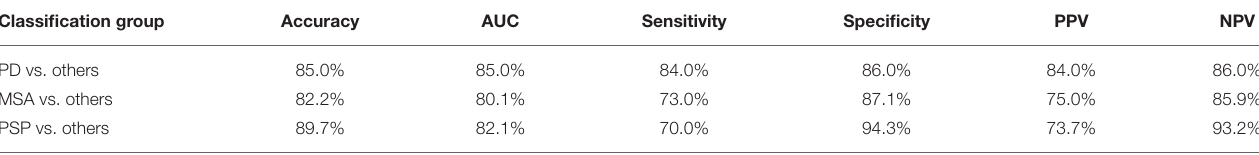
TABLE 3 | Diagnostic performances of the proposed computer-aided classification framework for the binary classification of different parkinsonian disorders. Classification group Accuracy AUC Sensitivity Specificity PPV NPV PD vs. others 85.0% 85.0% MSA vs. others 82.2% PSP vs. others